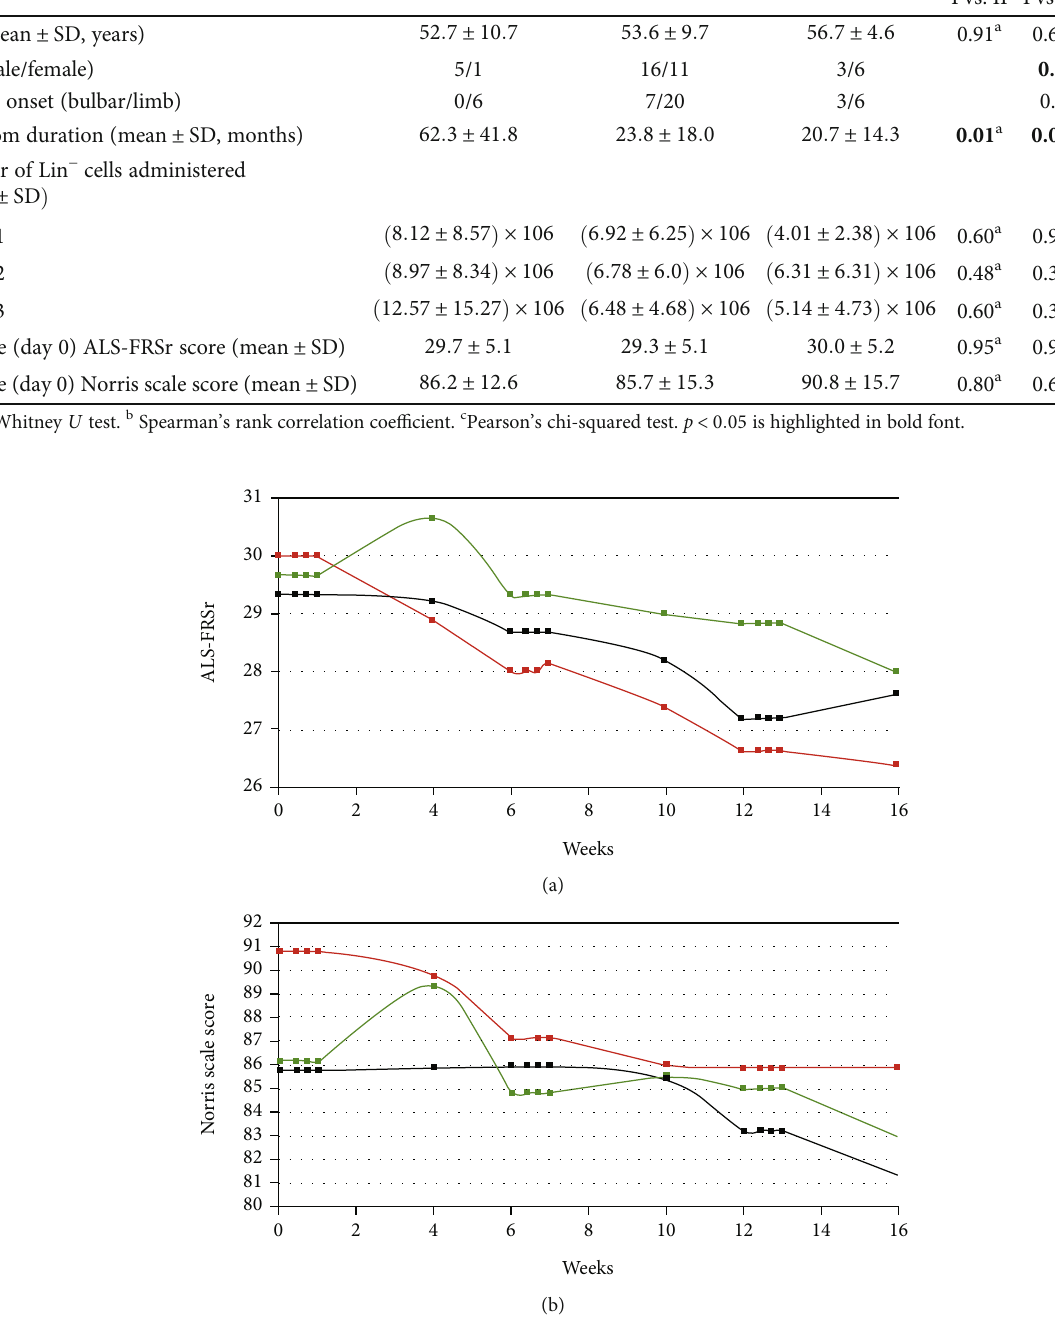
Figure 1: Functional assessment results with ALS-FRSr (a) and Norris scale (b) in three groups of sALS patients in time. Green — group I; black — group II; red — group III. The results are presented as the mean values. Squares represent the analyzed